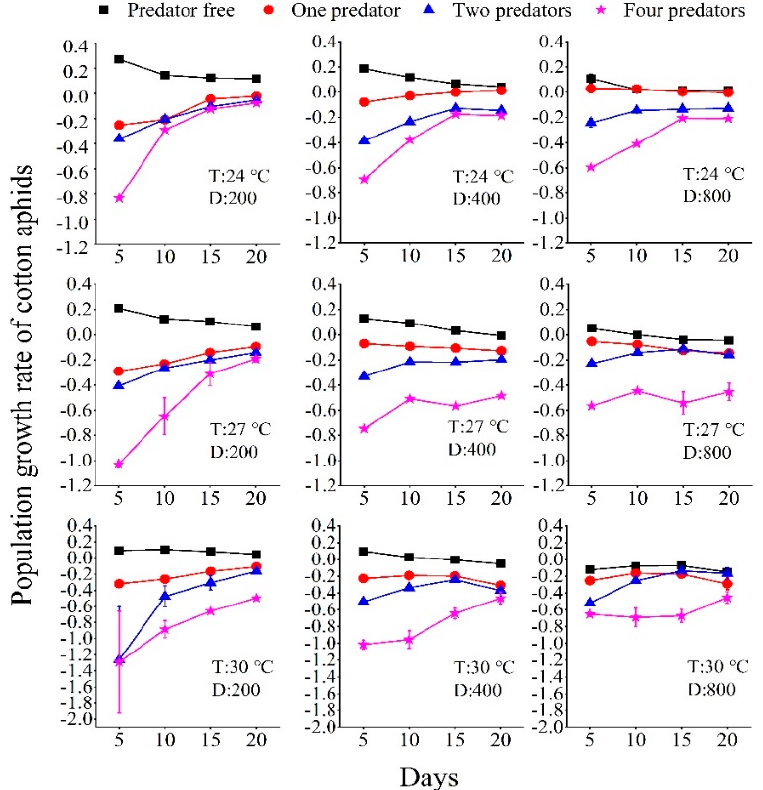
Figure 1. Population growth rate of cotton aphids in laboratory experiments using three initial numbers of aphids (200, 400, and 800), four numbers of predator beetles (0, 1, 2, and 4), and three constant temperature regimes (24 ◦ C, 27 ◦ C, and 30 ◦